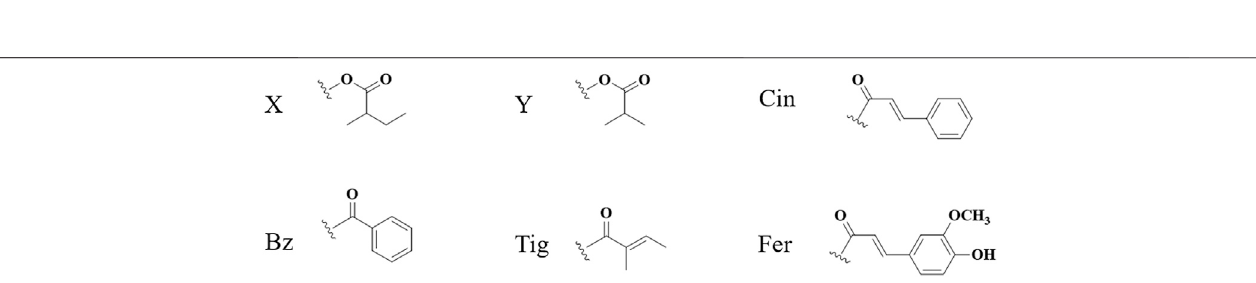
FIGURE 7 | Abbreviation of